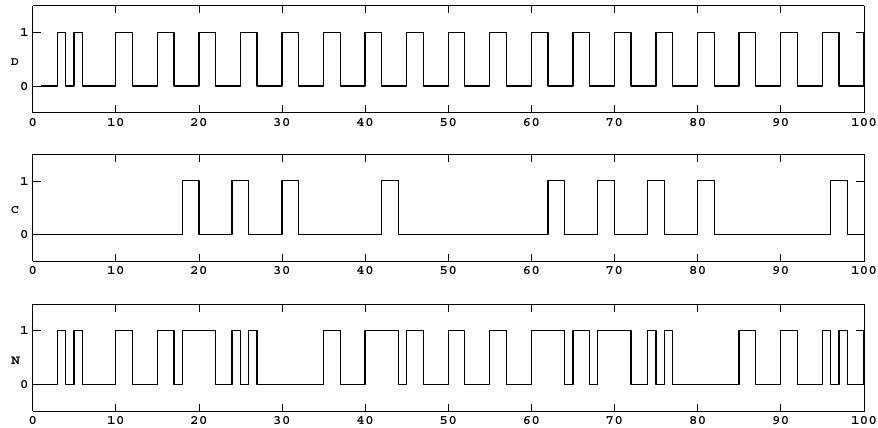
Figure 10. Sequences { D i } , { C j } and { N k } obtained from the Chua (Matsumoto) circuit and logistic map with µ = 3.99 and a relatively small number of precision bits resulting in a nonchaotic sequence { D } . The first 100 bits are shown from each sequence of 5000 bits. i